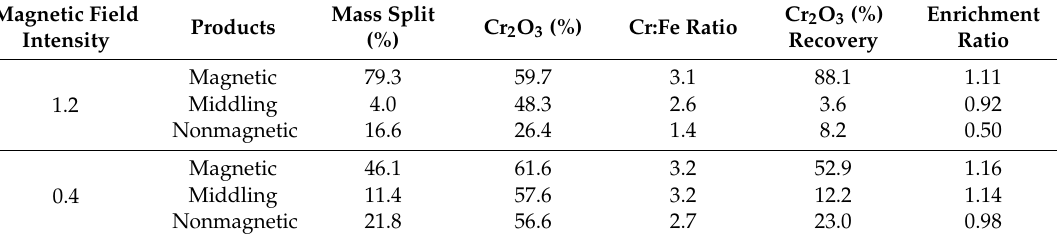
Table 8. Results of the two-stage separation in the WHIMS for the fine concentrate.